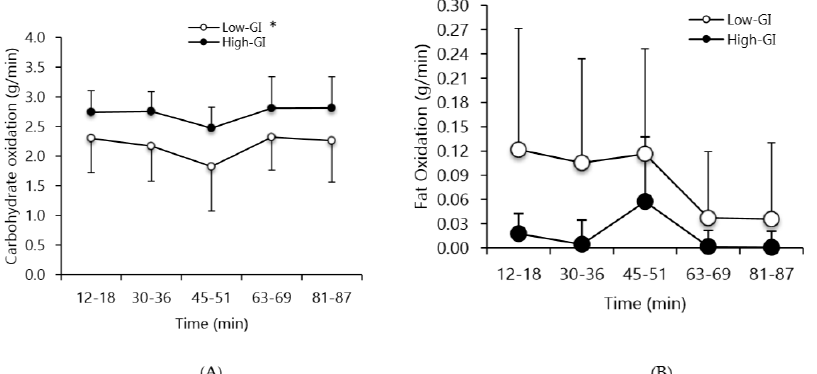
Figure 5. ( A ) Rate of carbohydrate oxidation, ( B ) and fat oxidation during the simulated soccer match in the low glycemic index and high glycemic index conditions. Values are means and SD. *Main effect for condition for carbohydrate oxidation, with the low-GI condition lower than the high-GI condition; p < 0.05. There was a time main effect ( p < 0.05) for fat oxidation (45–51 min > 63–69 min, 81–87 min; p < 0.05).